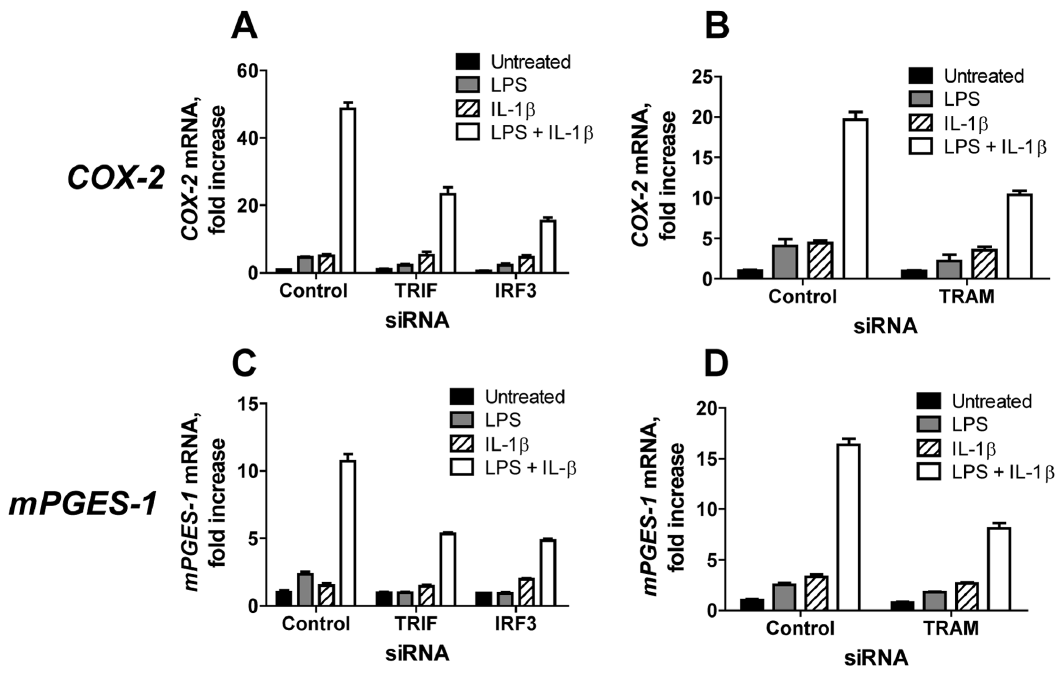
Figure 8. IRF3, TRIF, and TRAM siRNA reduced COX-2 and mPGES-1 in rIL-1 b -treated LPS-primed U373-CD14 cells. U373-CD14 cells were transfected with control siRNA or with siRNA targeting TRIF or IRF3 (A, C), or TRAM (B, D). Transfected cells were left untreated (solid bars), or were incubated with LPS at 1 ng/ml (shaded bars), with rIL-1 b at 100 ng/ml for 18 h (striped bars), or were primed for 1 h with LPS and incubated with rIL-1 b for additional 18 h (open bars). Cells were collected and COX-2 mRNA (A, B) and mPGES-1 mRNA (C, D) expressions were assayed by qPCR. The data are shown as fold increase over control PCR with primers specific to b -actin , run in the same samples. PCR was performed using triplicate wells and the data are shown as mean fold increase 6 STDEV. This is representative of three experiments.